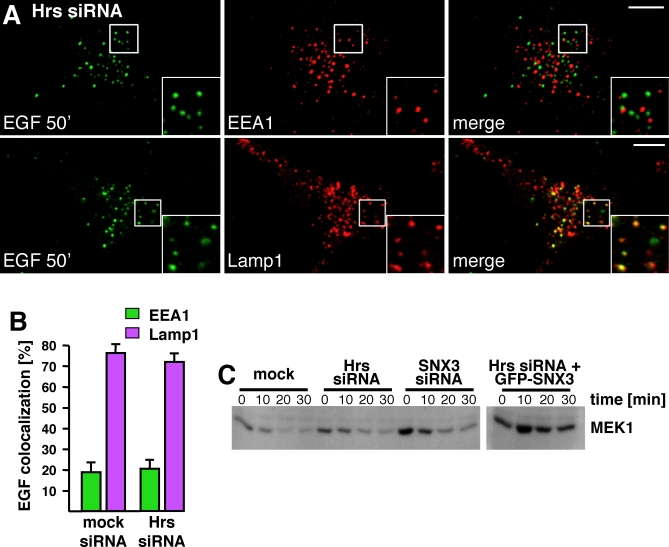
MEK1 Cleavage by Anthrax Toxin Lethal Factor(A and B) Experiments (A) and quantification (B) were as in Figure 4G and 4H, except that cells were treated with Hrs siRNAs. Insets in the lower right are a magnification of the regions shown in the boxes.(C) Hrs or SNX3 was knocked down, or Hrs was knocked down and GFP-SNX3 overexpressed. The trypsin-nicked Protective Antigen (500 ng/ml) and the Lethal Factor (100 ng/ml) of anthrax toxin were then bound to the cell surface on ice [51], and cells were incubated at 37 °C. Lysates (40 μg) were analyzed by western blotting using antibodies against MEK1 N-terminus to detect MEK1 cleavage by Lethal Factor released into the cytosol.In (B), each condition is the mean of at least three independent experiments; standard errors are indicated. (A) Scale bar indicates 10 μm.